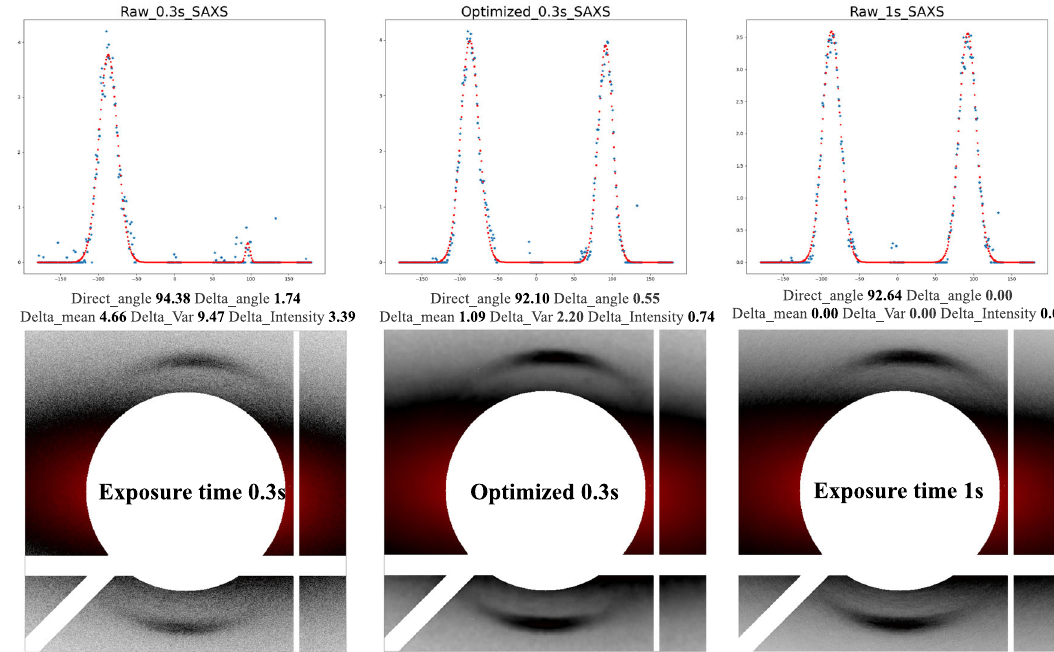
Fig. 3 Upper row: Radial integration on P i , P i , P i (blue) and Gaussian fi tting (red). Visually, the optimized result shows the recovered 0 : 3 0 : 3 opt 1 peak shape compared to raw data, and quantitatively the orientation (Direct Angle), Delta Angle (orientation difference), Delta Mean, Delta Variance, Delta Intensity of the optimized are all closer to the reference 1s-exposure time data. Lower row: SAXS images corresponding to 0.3 s, SEDCNN4-optimized 0.3 s and 1 s exposure time. The diffraction patterns of the optimized are visually more obvious than the raw data, closer to the reference